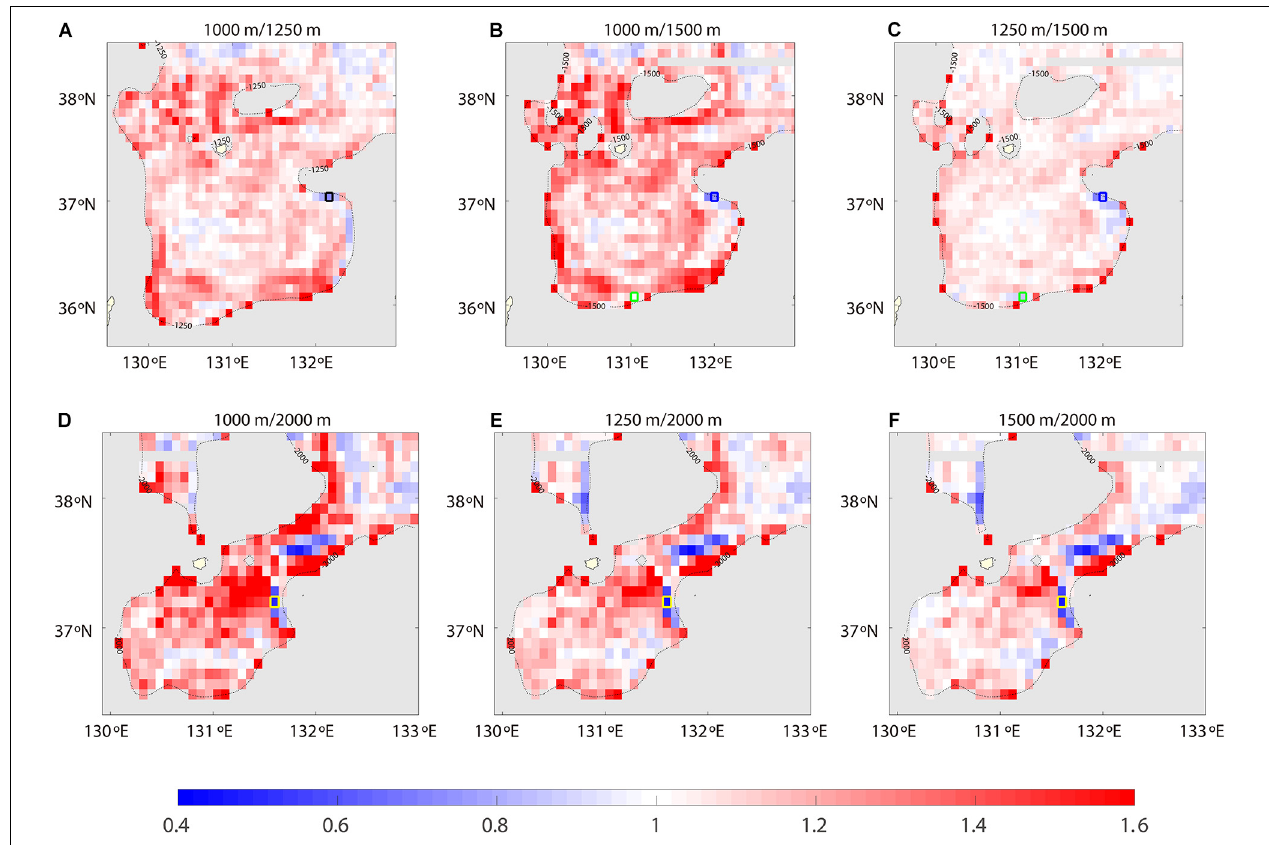
FIGURE 8 | Spatial distribution of R for the longer intraseasonal band between two different depths for (A) 1000 and 1250 m, (B) 1000 and 1500 m, (C) 1250 and 1500 m, (D) 1000 and 2000 m, (E) 1250 and 2000 m, and (F) 1500 and 2000 m. Grids where R is below 1 indicate bottom intensification and the four selected cases where the bottom intensification is distinct are marked by